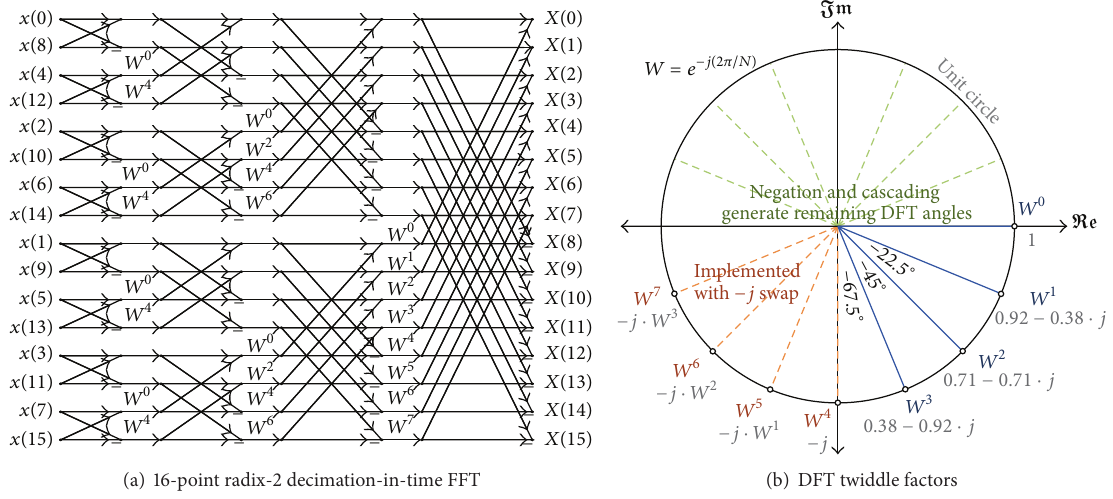
Figure 12: A 16-point radix-2 decimation-in-time FFT (a) and DFT twiddle factors coefficients on the unit circle